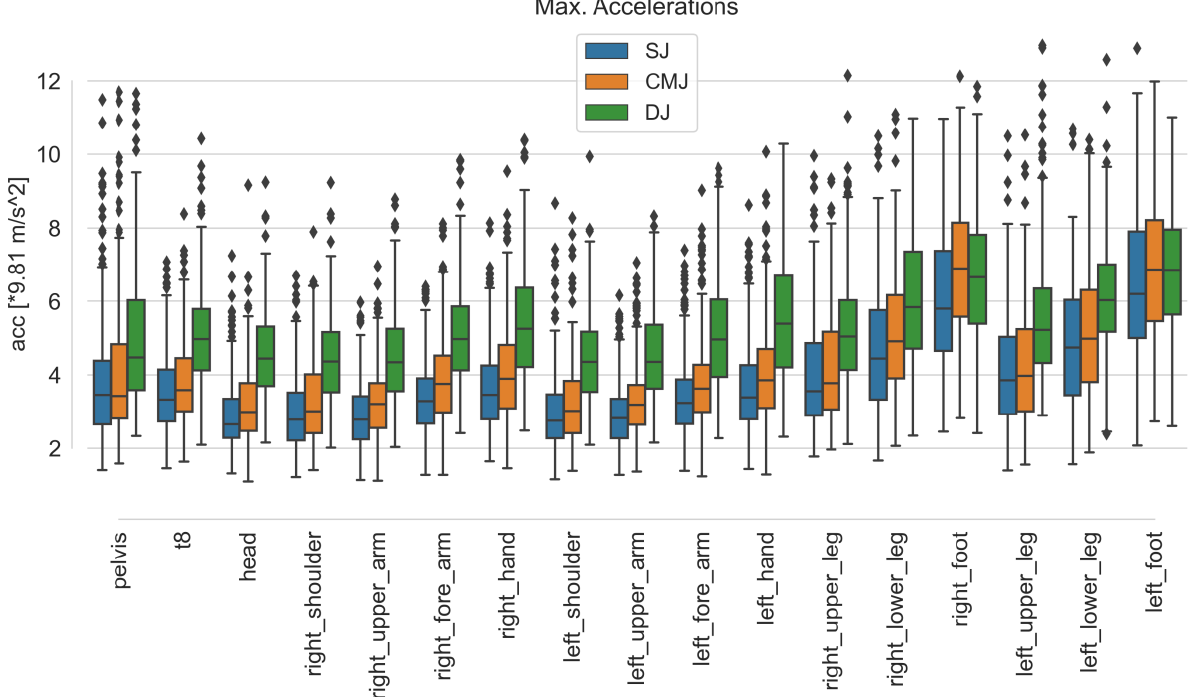
Figure 3. Boxplots of maximum accelerations in gravitational direction over all subjects and trials for each sensor and exercise.